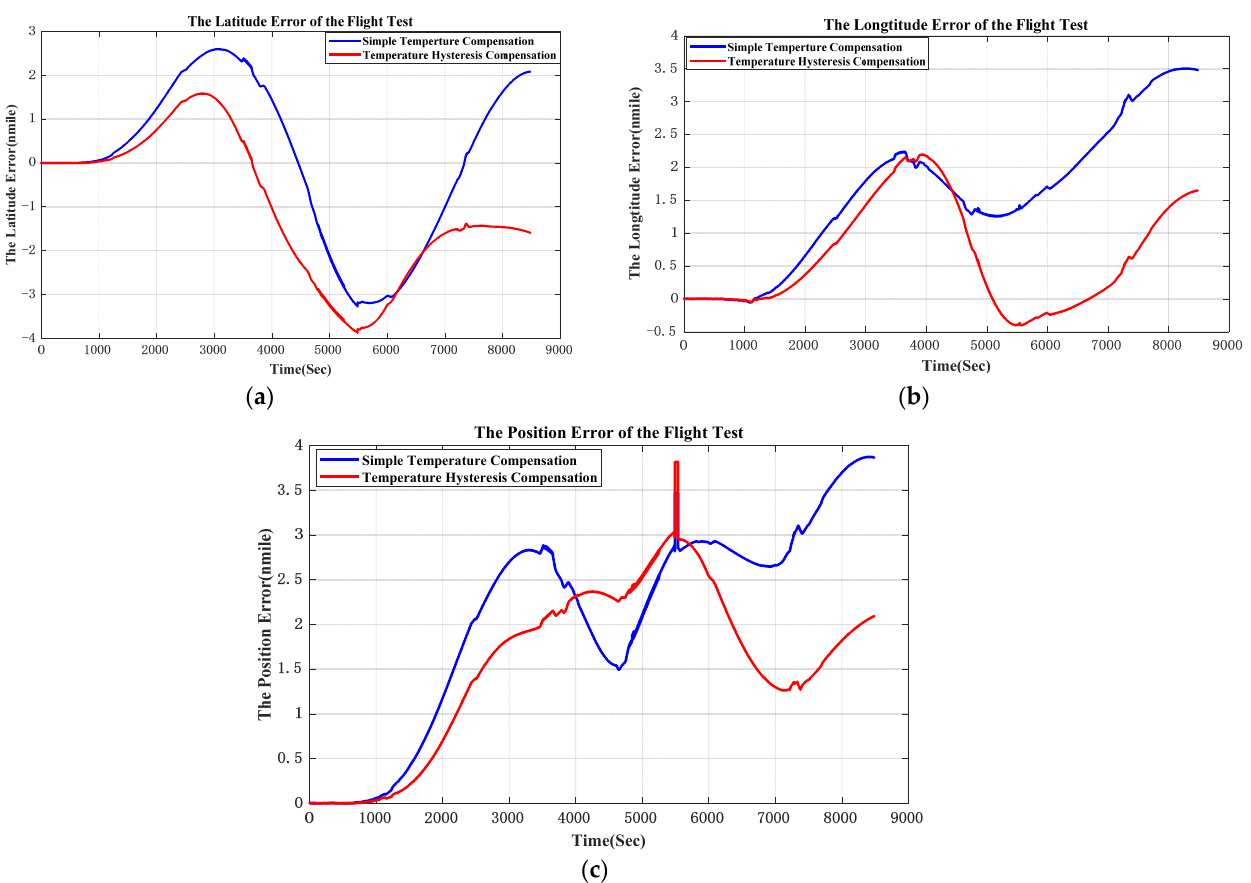
Figure 13. ( a ) is latitude error of the flight test; ( b ) is longitude error of the flight test; ( b ) is position error of the flight test. In ( b ) and ( c ), because the GPS signal was smoothened by simple linear regression, small mutations in position calculation appeared when GPS signal loss.